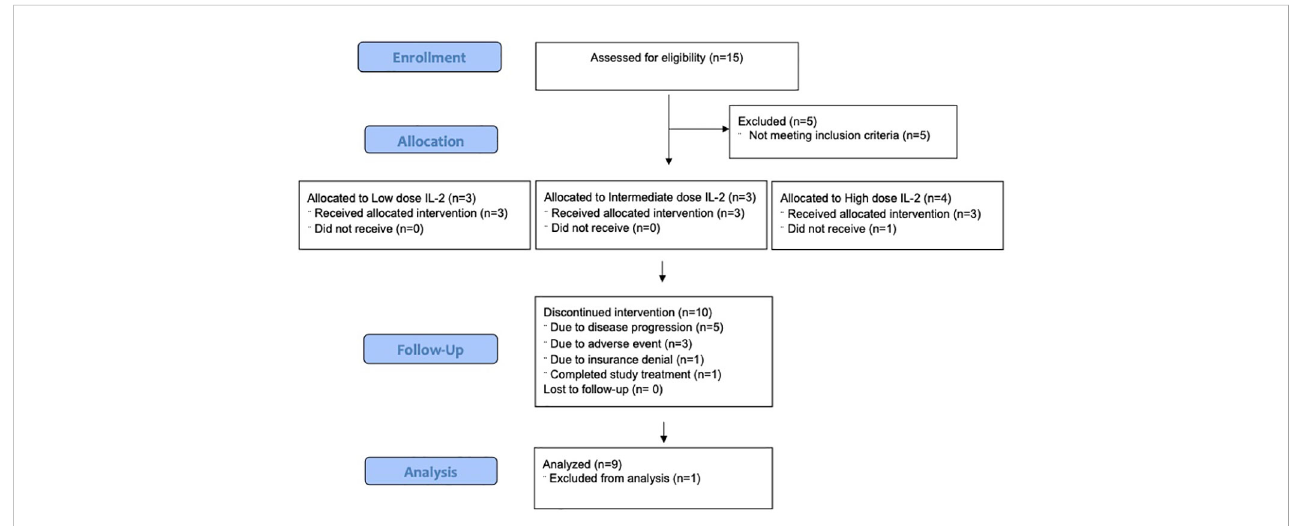
FIGURE 2 CONSORT